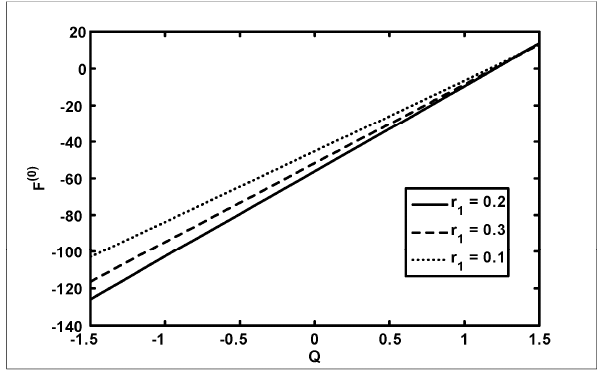
r at 3,φ 0.4, M = = when 1